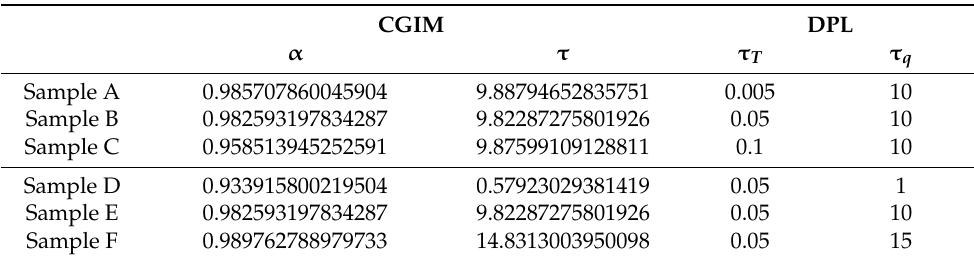
Figure 6. Jacobian coefficient for test case 2 ( a ) time-lag Jacobian coefficient and ( b ) fractionality Jacobian coefficient. Table 1. Estimation values of fractionality and time-lag in the conjugate gradient method in three samples for test case 2.